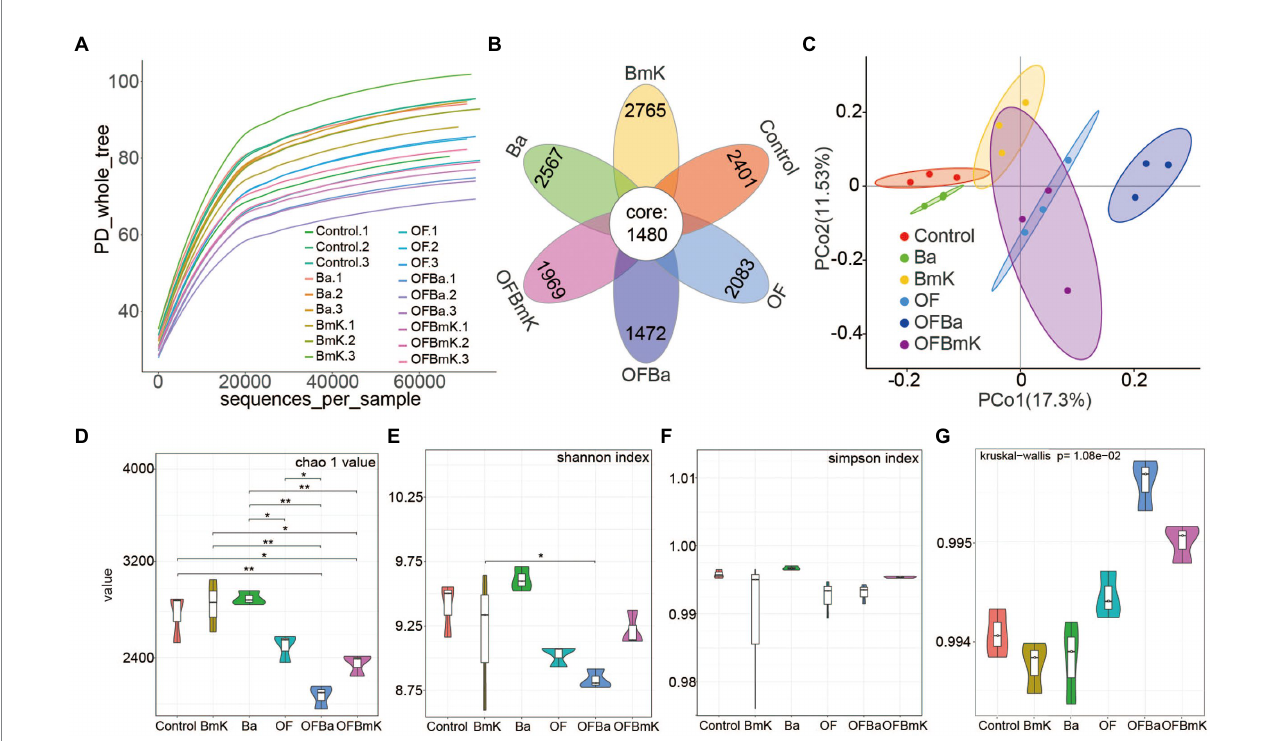
FIGURE 3 Microbial diversity in the rhizosphere of Dendrocalamus farinosus under various fertilization conditions. (A) Diversity index dilution curve, where each curve represents a sample, the abscissa is the depth of random sampling, and the ordinate is the exponential value. (B) Venn diagram of the operational taxonomic units (OTUs) shared by all six conditions, and the number on each petal represents the total OTUs of each sample minus the number of shared OTUs. (C) Principal component analysis based on the binary_jaccard distance matrix. Analysis of Chao1 index (D) , Shannon index (E) , and Simpson index (F) related to bacterial alpha diversity. The Kruskal–Wallis algorithm was used to calculate the significance of the differences between treatment conditions (* p < 0.05, ** p < 0.01). (G) The Goods_coverage index was used to evaluate whether the sequencing results could reliably represent the real composition of microorganisms in the